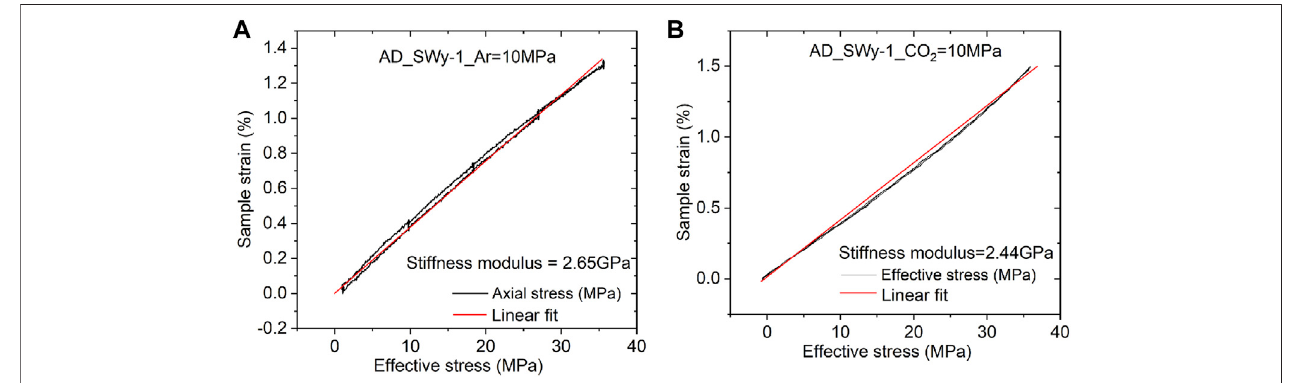
FIGURE 4 | Effective stress versus sample strain measured in the rapid stress cycling runs performed on the AD SWy-1 sample at the end of Stage 2 experimentation. (A) Stress-straindataobtainedincycleperformedusingwetAr.Bestlinear fi tshowsaconstrainedaxialstiffnessmodulusof2.65 GPa (B) Stress-strain data obtained in cycle performed using wet CO 2 . Best linear fi t shows a constrained axial stiffness modulus of 2.44 GPa.